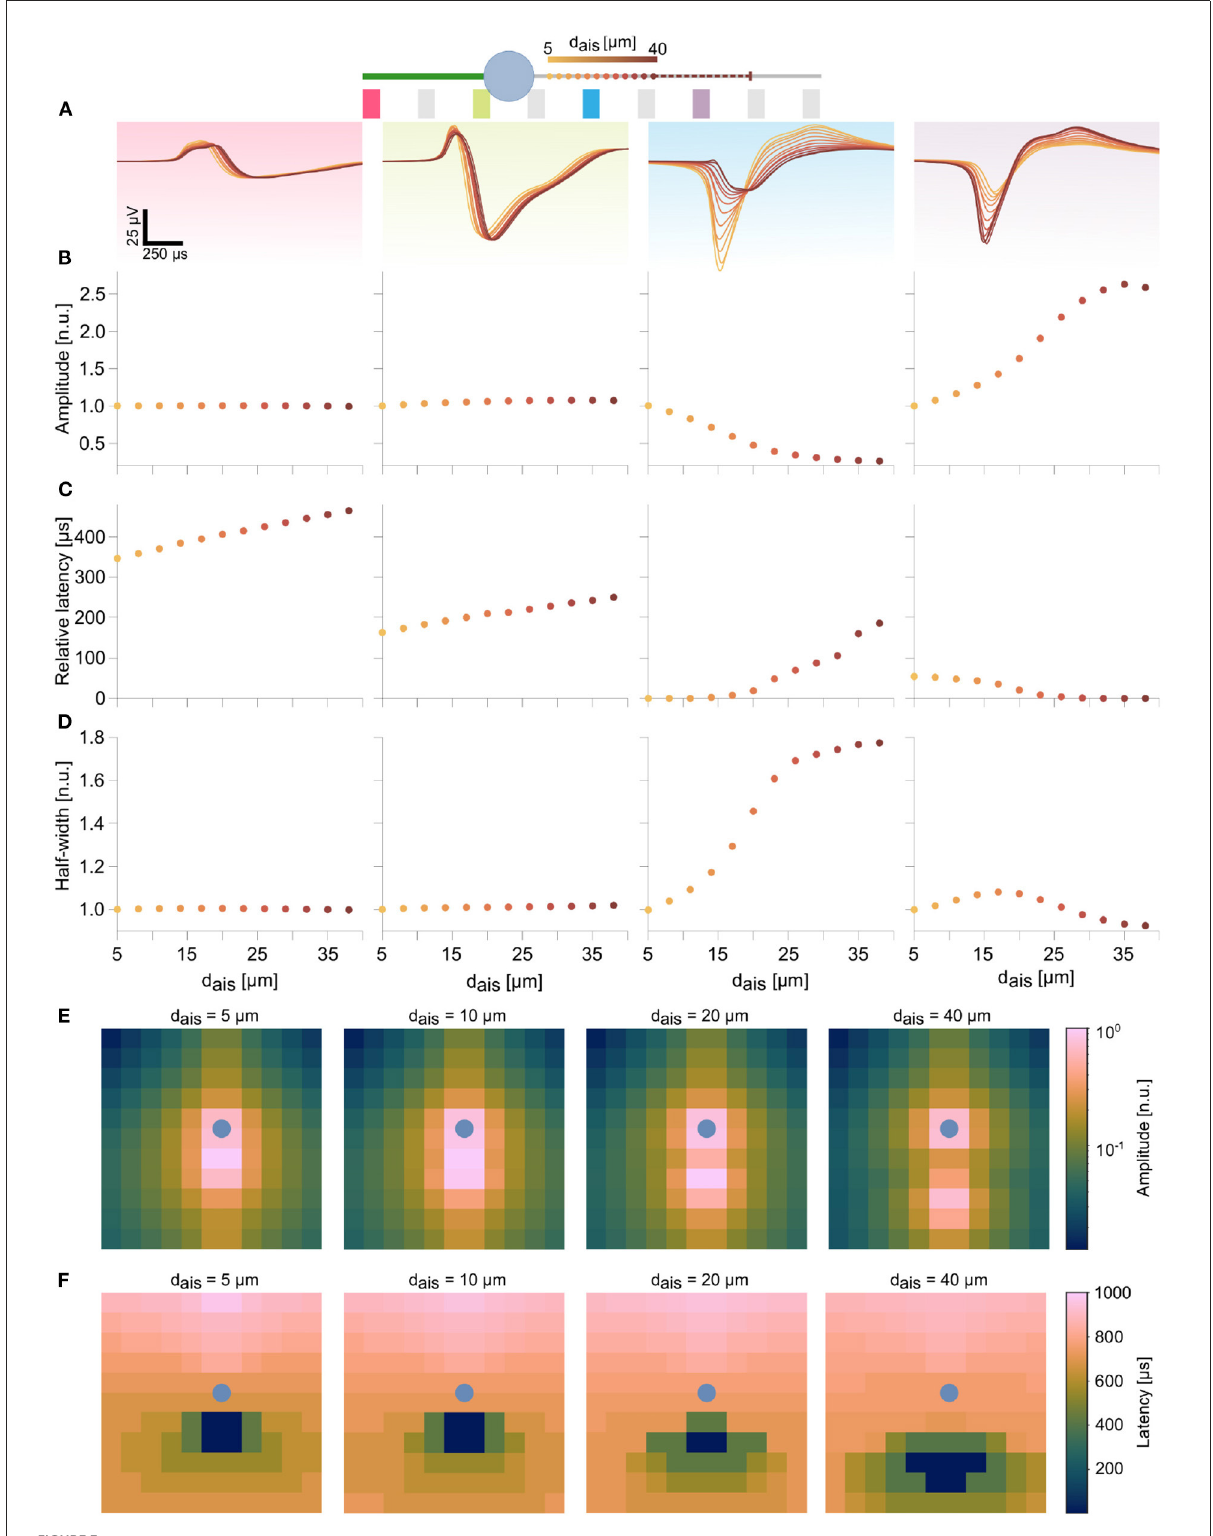
FIGURE3 Features in the extracellular footprint of the ball-and-stick model exhibited systematic changes in dependence of AIS relocation. (A) Waveforms at selected electrodes (pink, green, blue, and purple) along the neuron are shown for various AIS locations. Proximal AIS locations